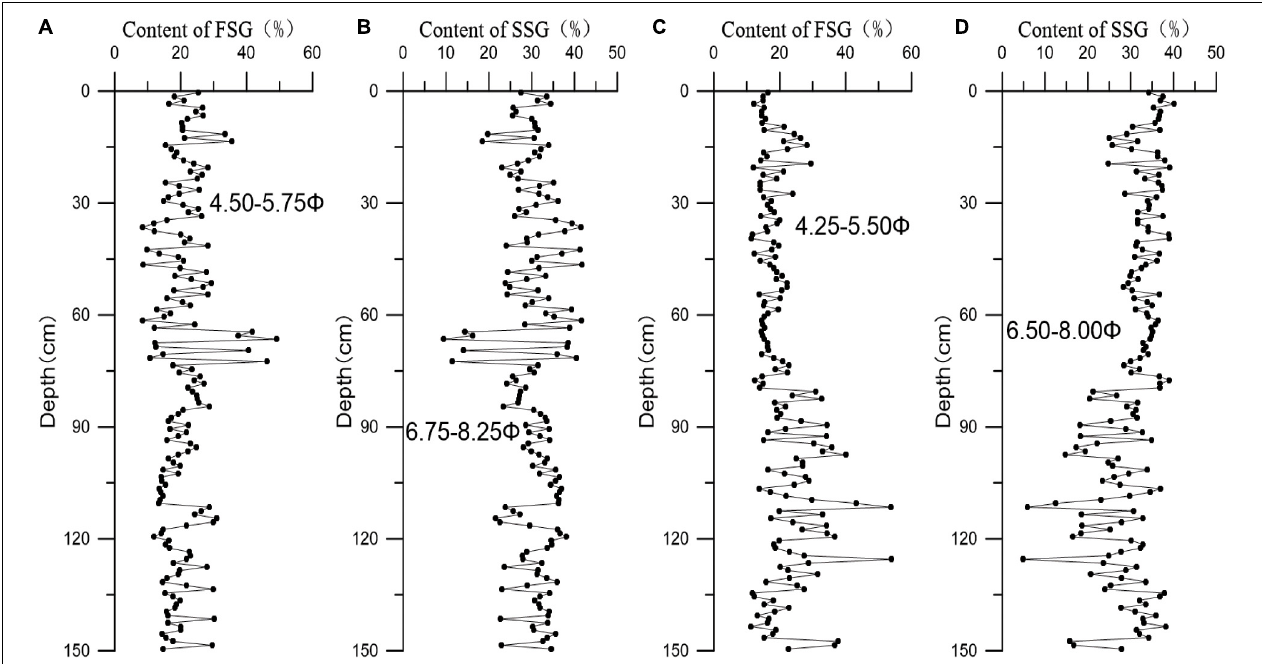
FIGURE 6 | Variations in content of two sensitive grain size fractions of cores Z7 (A,B) and Z8 (C,D) . FSG, first sensitive grain size; SSG, second sensitive grain